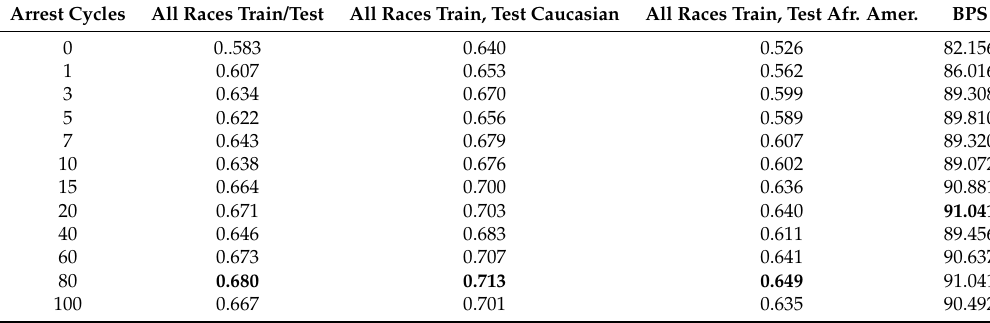
Table 4. Average true-negative